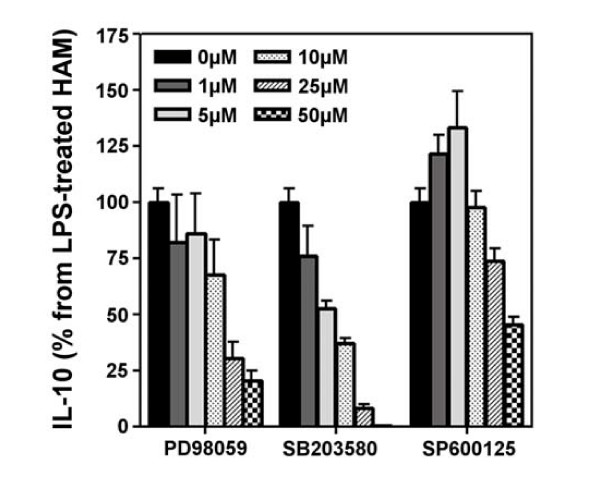
Effect of specific MAP kinase inhibitors on the production of IL-10 in HAM. HAM were preincubated (1 h) with increasing concentrations of inhibitors and then were stimulated with LPS (1 μg/ml) during 24 h. Supernatants were assayed to determine the production of IL-10 by ELISA.